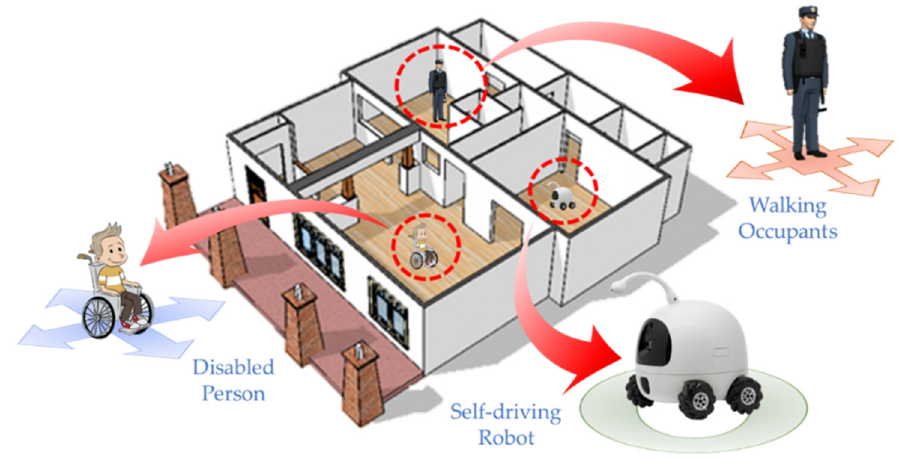
Figure 1. Various navigating occupants of indoor